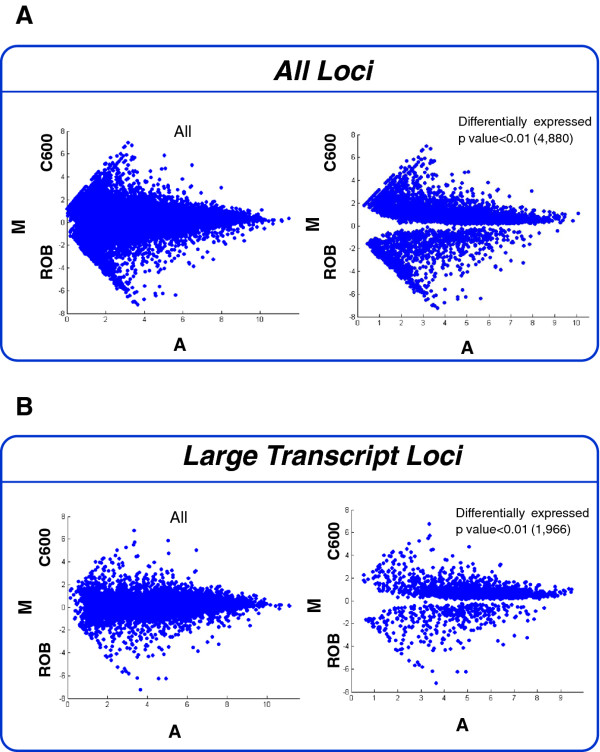
MA plots to show transcriptome-scale difference in genotype-dependent gene expression for loci with a normalized cut off of ≥ 10 tags in at least 1 test sample. A) Expression of all 23,460 loci in C600 versus Roberta genotype, of which 4,880 were differentially expressed as indicated. Expression values (normalised tag counts) were plotted on a log scale, so that the difference in expression is M = log2R - log2G and the average expression is A = 1/2 × (log2R + log2G); where R = C600 and G = Rob. B) Expression of all 13,125 large loci (> 500 bp with a tag count of > 10 in at least 1 sample) in C600 versus Roberta of which 1966 were differentially expressed as indicated.